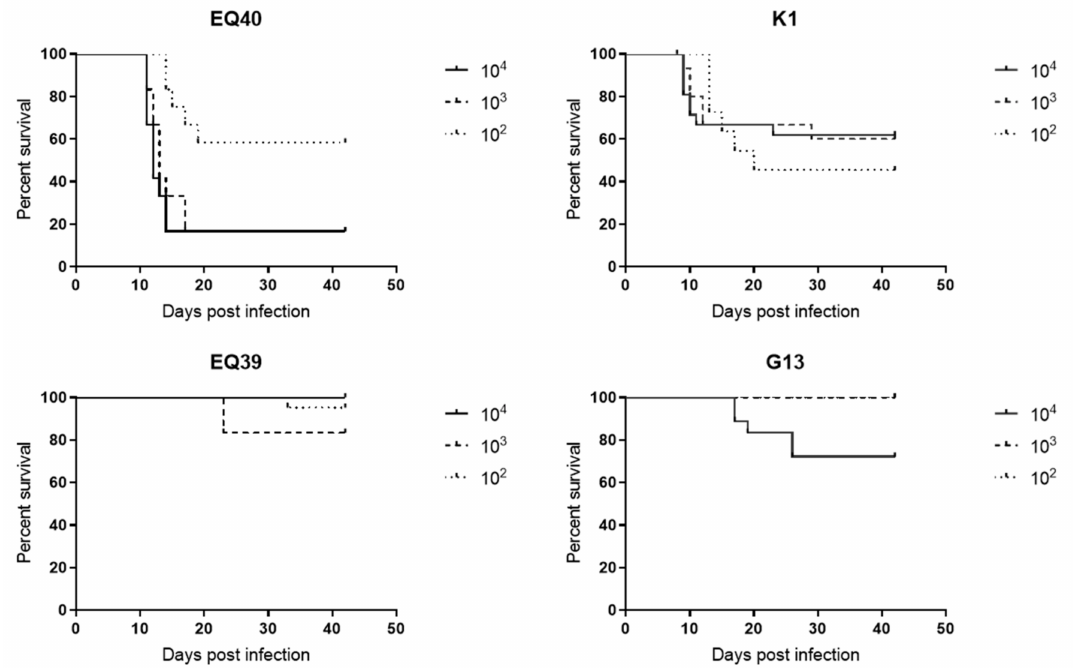
Figure 2. Survival curves of Swiss–Webster mice infected with di ff erent doses of tachyzoites of the lineage III isolates.